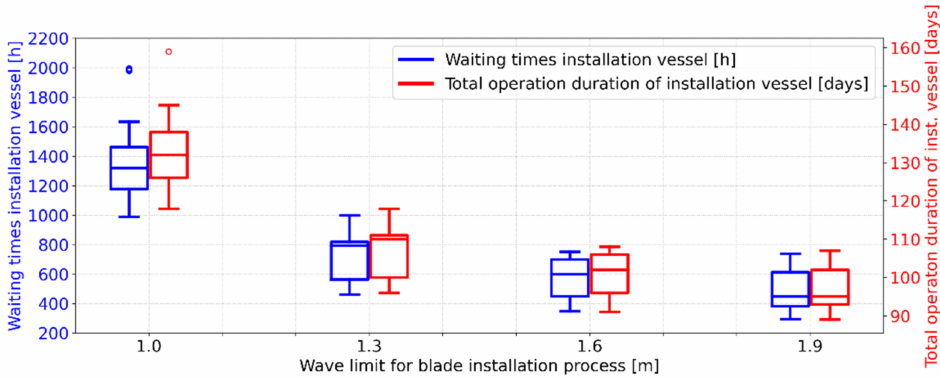
Figure 8. Distribution of waiting times and total operation duration depending on wave